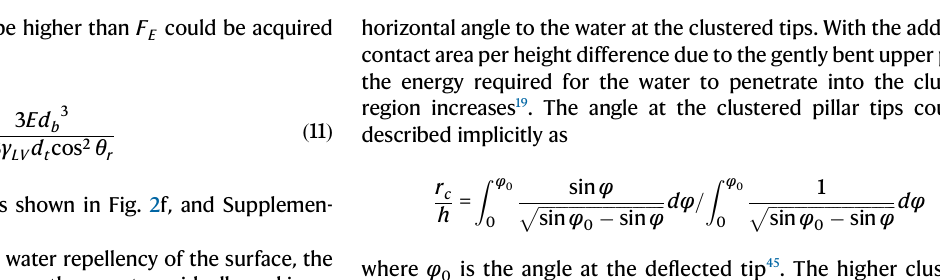
Fig. 1 | Overall concept of the research. a Hairs on the Salvinia leaves (left) and Salvinia -inspired hierarchical microstructures (right). Reproduced with permission 28 . B. Rice, sarracenia.com, Bugwood.org. Copyright 2010, Wiley.